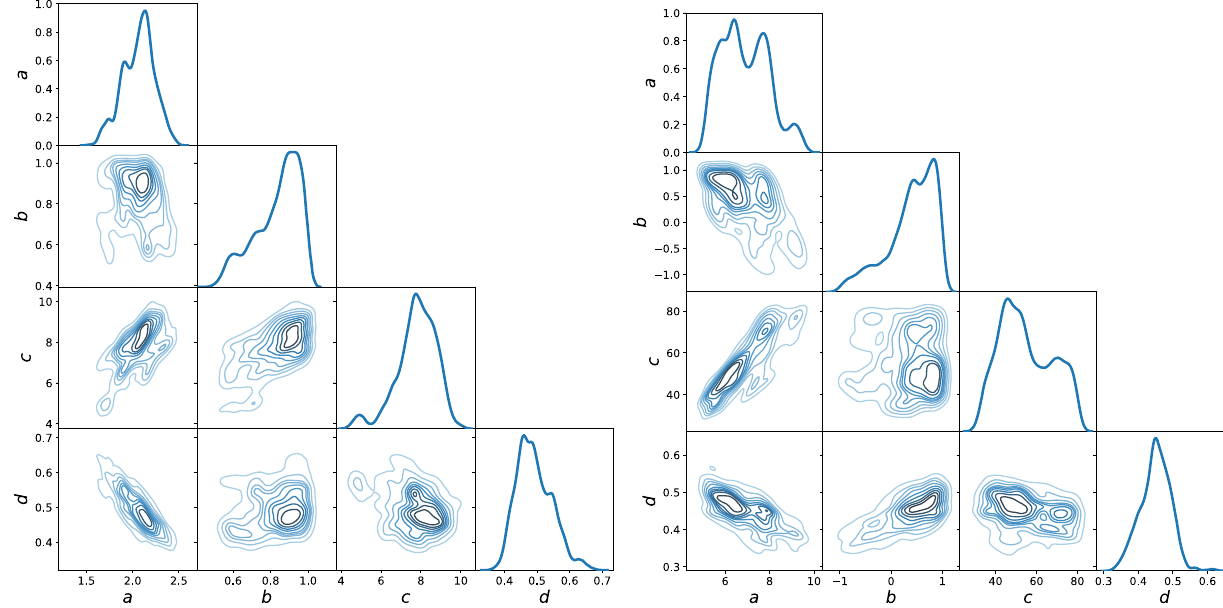
Fig. 2 The posterior probability distributions of the parameters a , b , c and d in the temperature-dependent coupling g ( T ) by fitting to the lattice equation of state from Wuppertal–Budapest (Left) and Hot QCD (Right) collaobrations